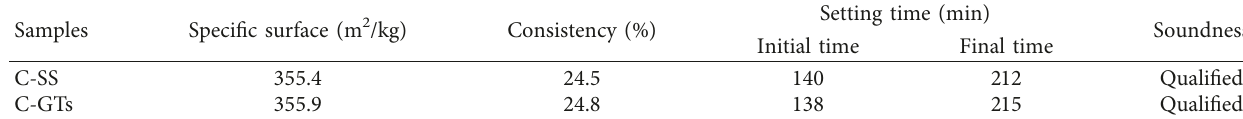
Table 3: Physical indices of two cements.